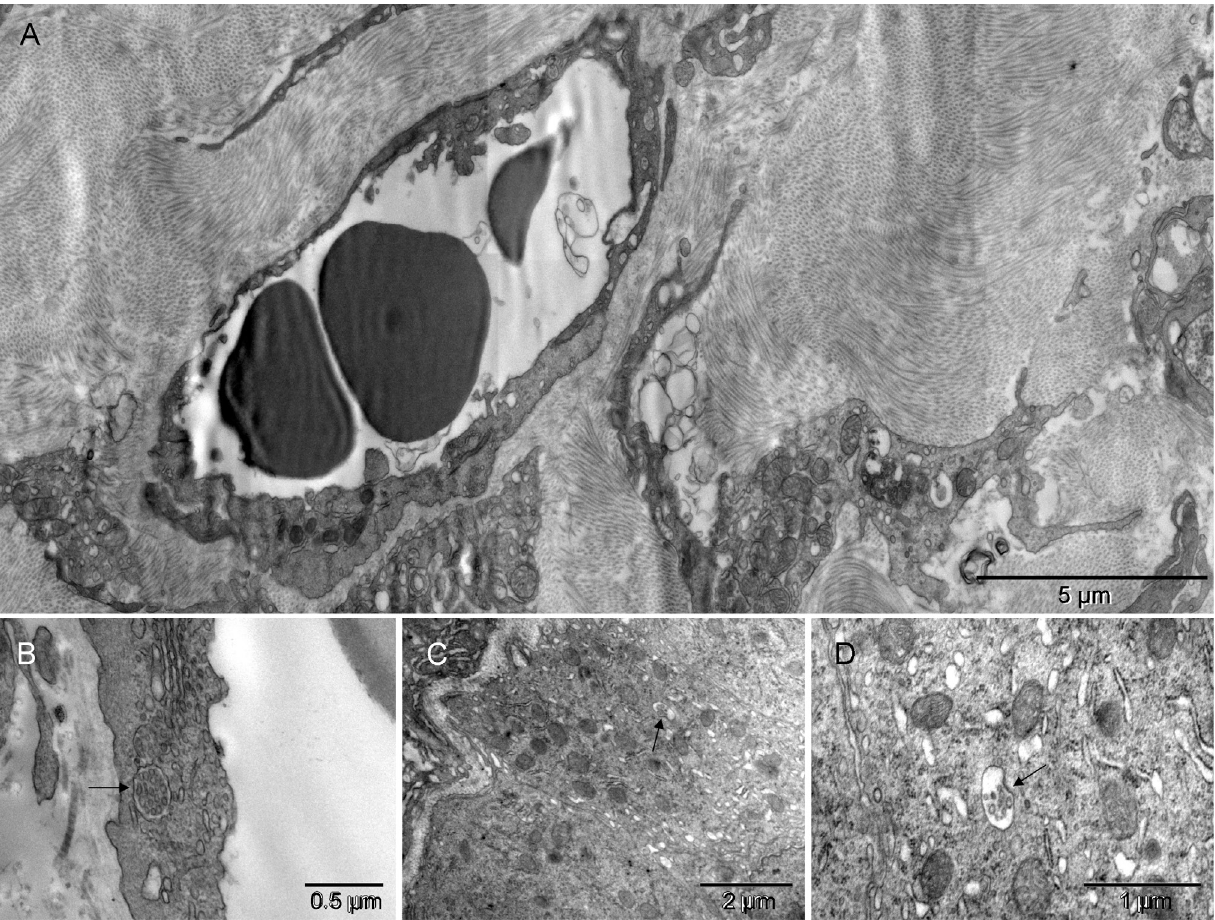
Figure 10. Role of collagen in morphogenesis of primitive vessels. The primitive vessels were embedded in copious amounts of collagen [ A ]. The wall of such vessels typically was polarized; it had caveolae on the luminal surface and collagen abluminally [ B ]. Collagen-making cell and tumor edges, accommodating each other’s curvatures, revealed interaction between the two [ C ]. The tumor seemed to benefit from collagen support provided by the nonmalignant neighbor as well as appearing to have acquired the ability to synthesize some by itself. Arrows in [ B , C & D ] point towards intracellular bundles of collagen fibers; [ D ] is the enlarged collagen-containing region of [ C ]. Dilated cisternae of endoplasmic reticulum depleted of ribosomes to a variable degree resembled vesiculo-vacuolar organelles (VVOs) 59 [ D